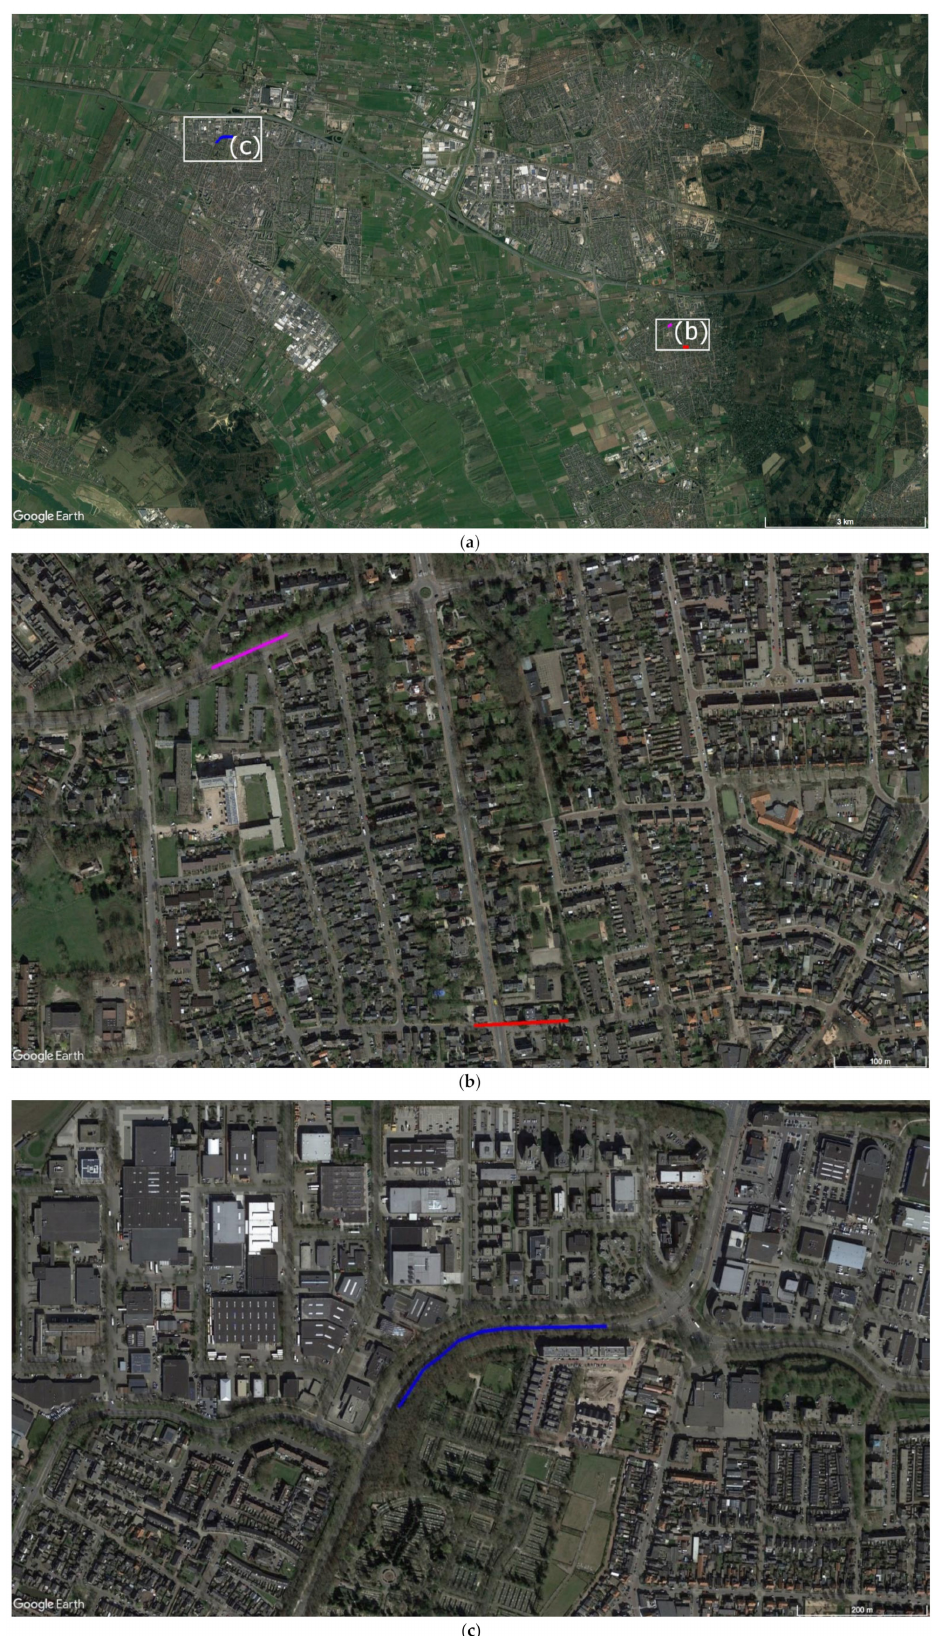
Figure 2. Satellite image overview ( a ) of the subsequent east to west video-recorded locations of wolf 6 in one night: ( b ) in red and pink in Bennekom; ( c ) in blue in Veenendaal. Images: ©Google